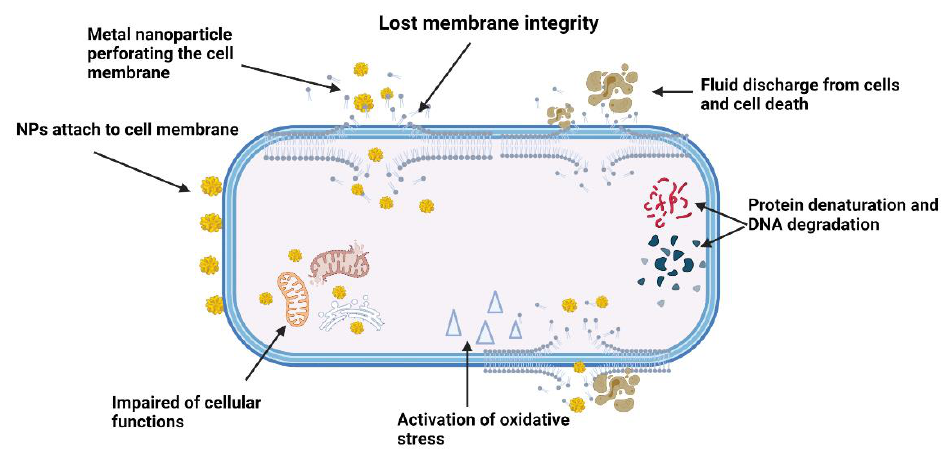
Figure 5. The schematic mechanism of actions of metal nanoparticles on bacterial cell membrane after successfully entering the biofilm matrix.